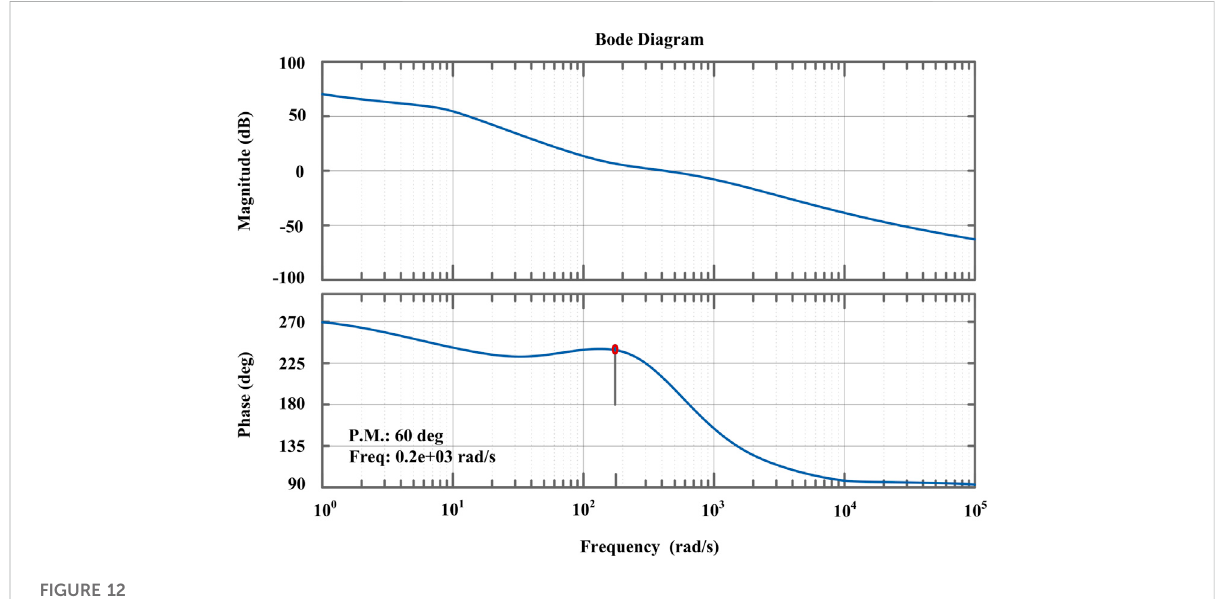
FIGURE 12 Bode plot of VCL for HESS.